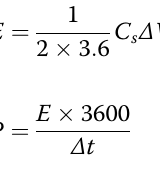
Figure S3. GCD curves of the samples obtained at different reaction time. (a) 2h; (b) 4h; (c) 8h. Figure S4. SEM images of the NiO flakes@CoMoO 4 NSs/NF obtained at different reaction time Figure S5. SEM images of NiO flakes@CoMoO 4 nanosheets obtained at (a) 120°C, (b) 140°C, (c) 160°C and (d) 180°C; (e) GCD curves at 1 A/g of NiO flakes@CoMoO 4 nanosheets obtained at different temperatures Figure S6. CV curves and GCD curves of (a, c) NiO flakes/NF and (b, d) CoMoO 4 flakes/NF Figure S7. GCD curves of (a) NiO flakes/NF//AC/NF and (b) CoMoO 4 flakes/NF//AC/NF. Table S1. Fitting of Nyquist plots for the researched three electrodes (DOCX 6402